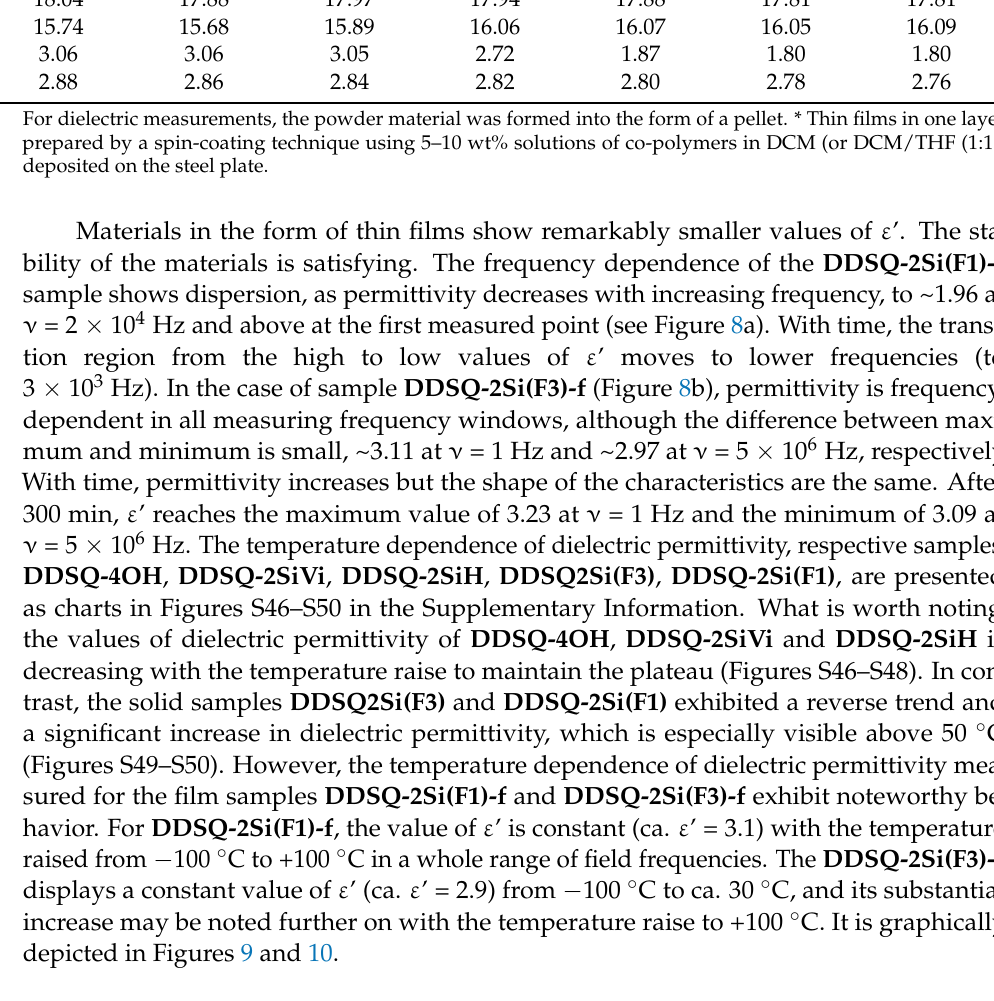
Table 1. Values of dielectric permittivity, measured at 20 ◦ C at 10 0 × 10 6 Hz.